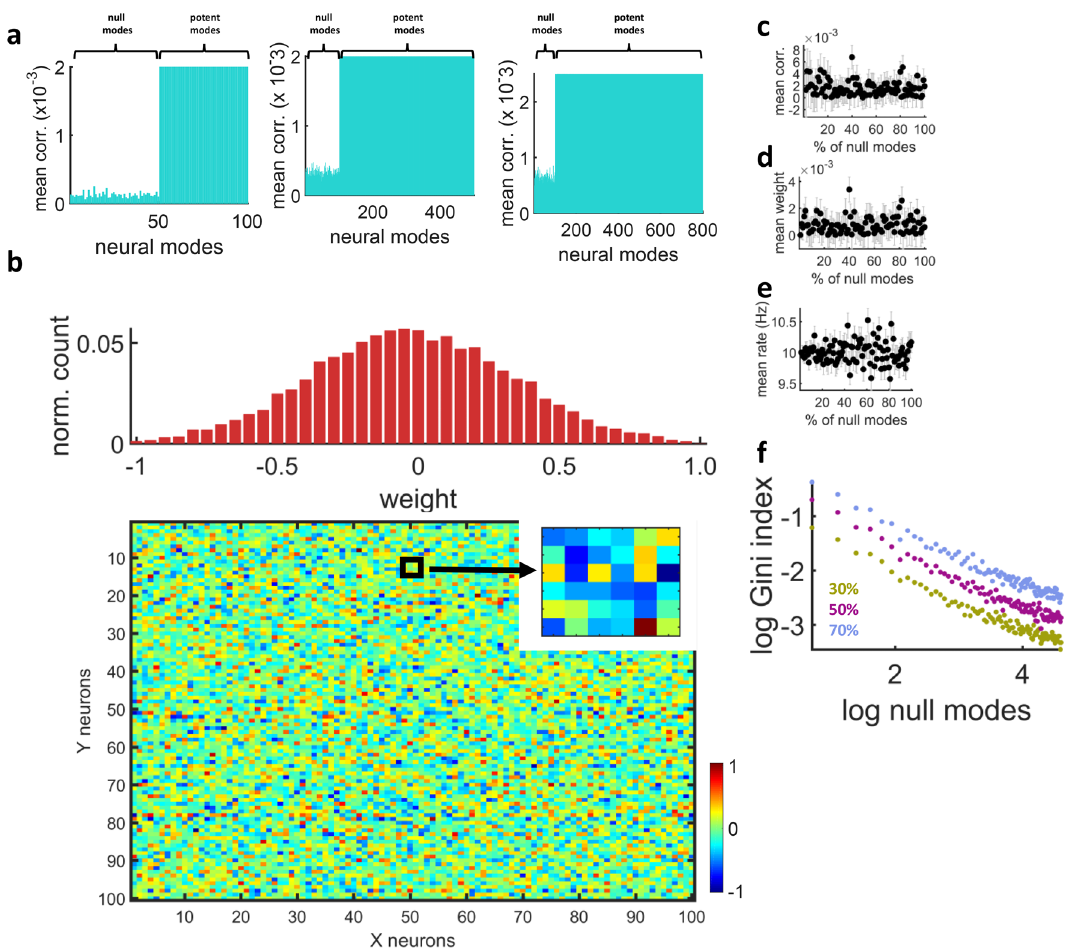
Figure 3. Null modes were not straightforwardly reflected in synaptic weight distribution, firing rates, pairwise correlations, or mean synaptic weights. ( a ) Correlation between modes of the sender and receiver areas with N = 100, 500, or 800 units and 50, 400, and 700 potent modes, respectively. ( b ) Connection weights between sender and receiver areas. Inset shows a portion of the figure. ( c ) Absolute mean pairwise correlation in different runs of the model where the percentage of null modes was altered. Vertical bars are standard error of the mean across 100 independent runs of the model. ( d ) Absolute mean synaptic weight in relation to the percentage of null modes. ( e ) Mean activity of the sender area versus null modes. ( f ) Gini index of the feedforward connectivity matrix. A threshold was applied to convert real-valued weights to a binary adjancency matrix where a given percentage of strongest connections was